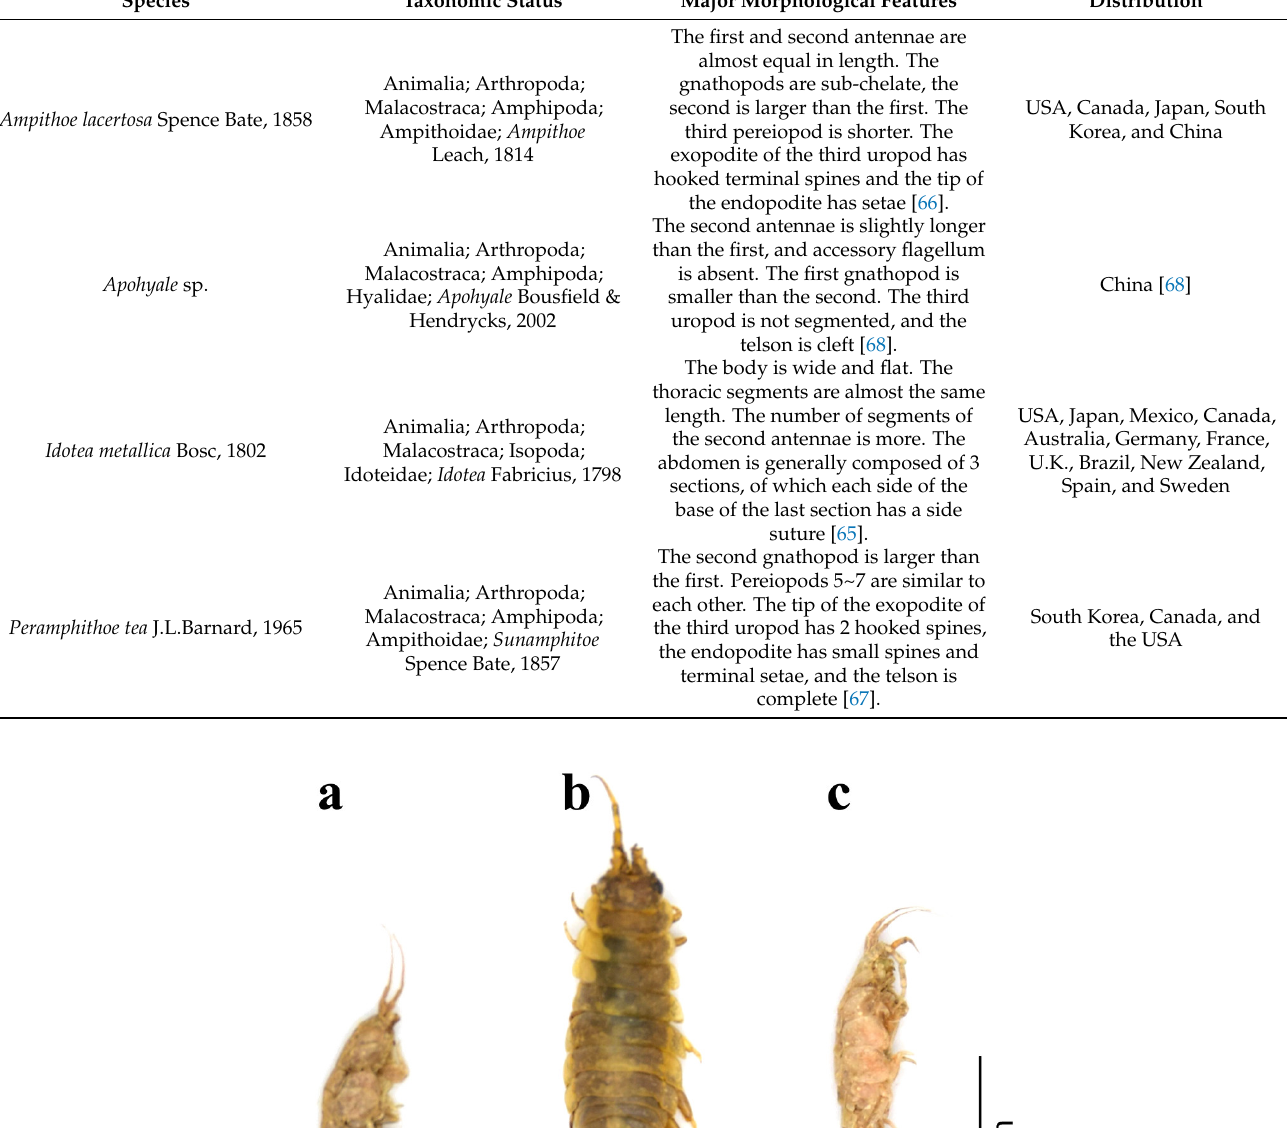
Table 3. Taxonomy, major morphological features, and distribution of epizoans.